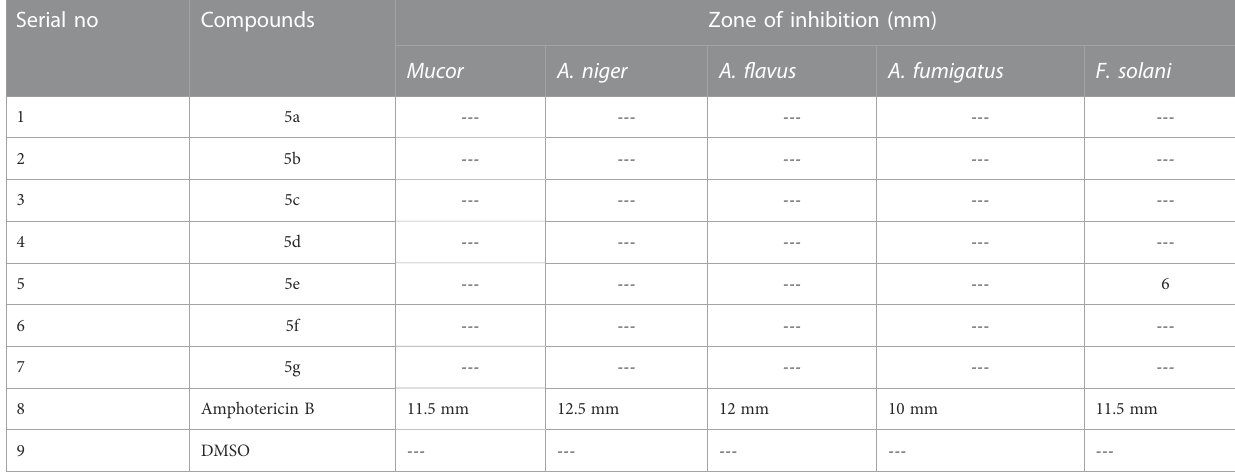
TABLE 4 Antifungal evaluation of the synthetic compounds